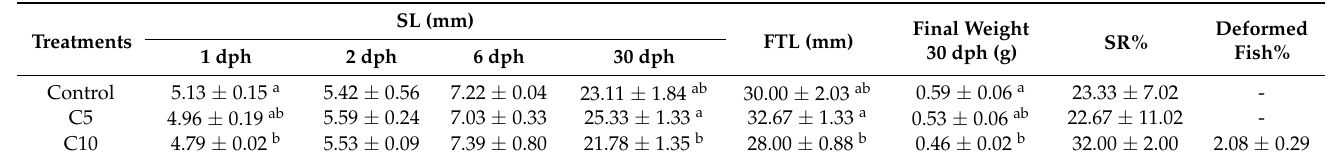
Table 2. Standard length (SL) (mm), final total length (FTL) (mm), final weight (g), and survival rate (SR%) of red tilapia exposed to CoQ10 (0, 5, and 10 mg/L). SL (mm)